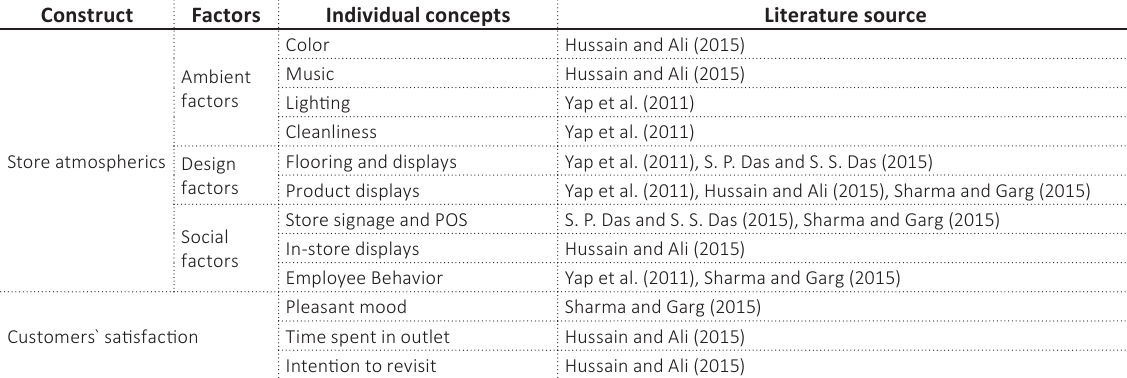
Table 2. Questionnaire